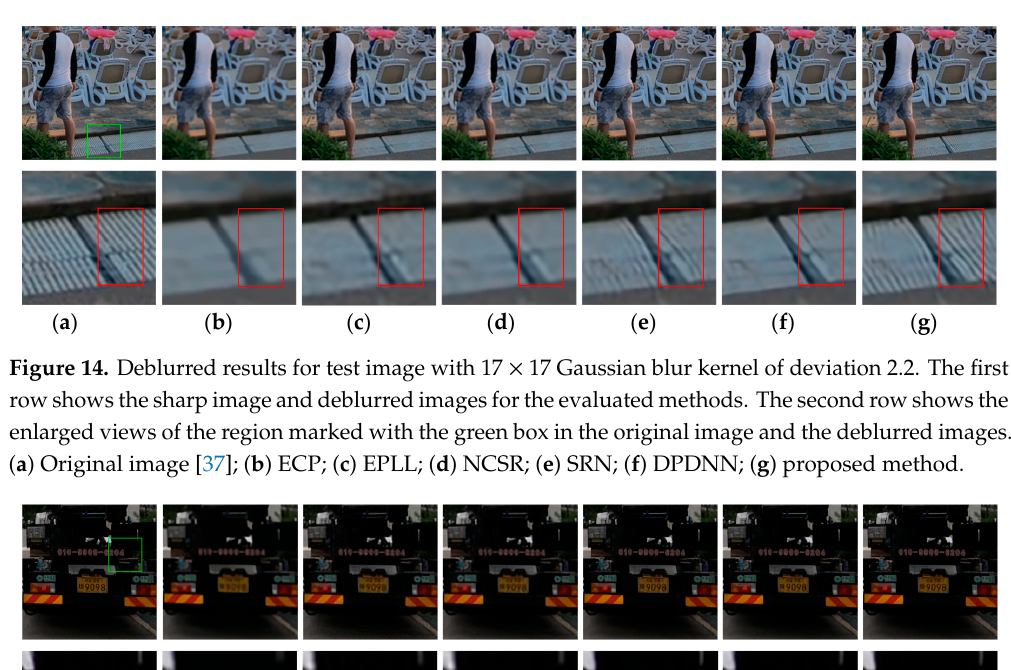
Table 3. The PSNR results of deblurred images for all evaluated methods.